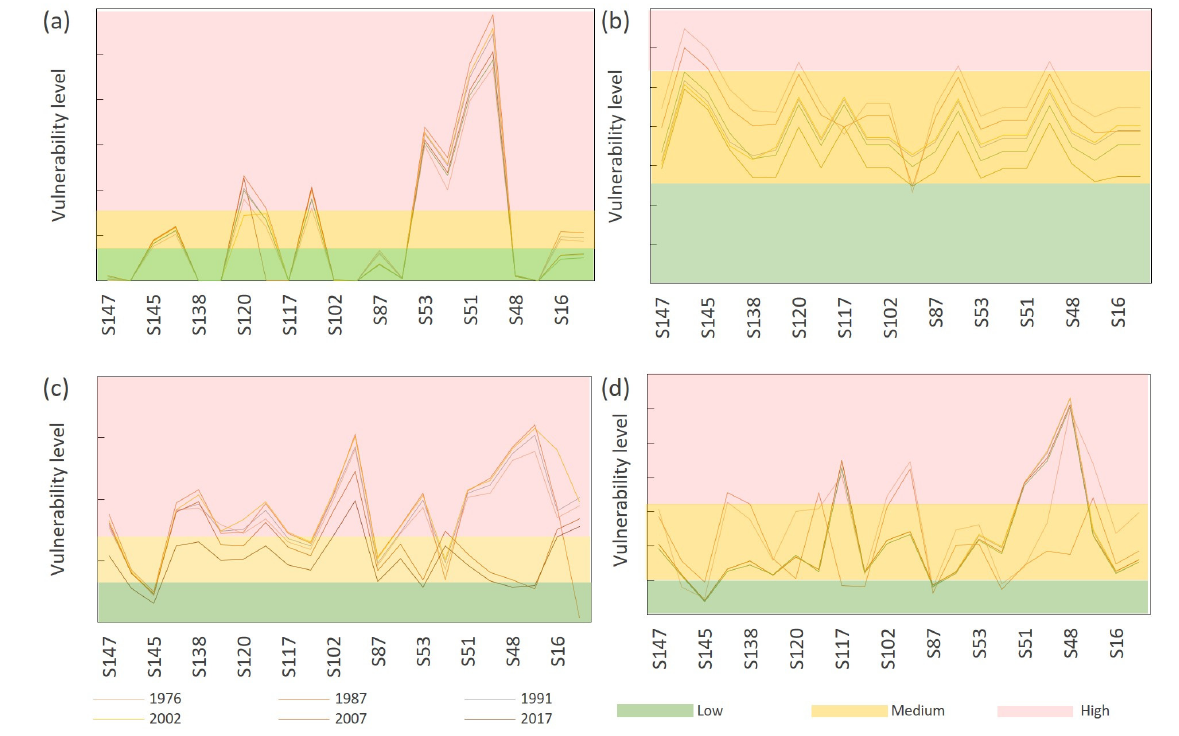
Figure 5. Evaluation of the physical vulnerability to floods by applying the following methods: ( a ) vulnerability and mapping of floods based on land-use patterns (MFLUP); ( b ) vulnerability in land-use change scenarios (VLUCS); ( c ) vulnerability based on flow velocity and curve number (VFVCN); and ( d ) vulnerability based on soil water storage variation (VVHu).